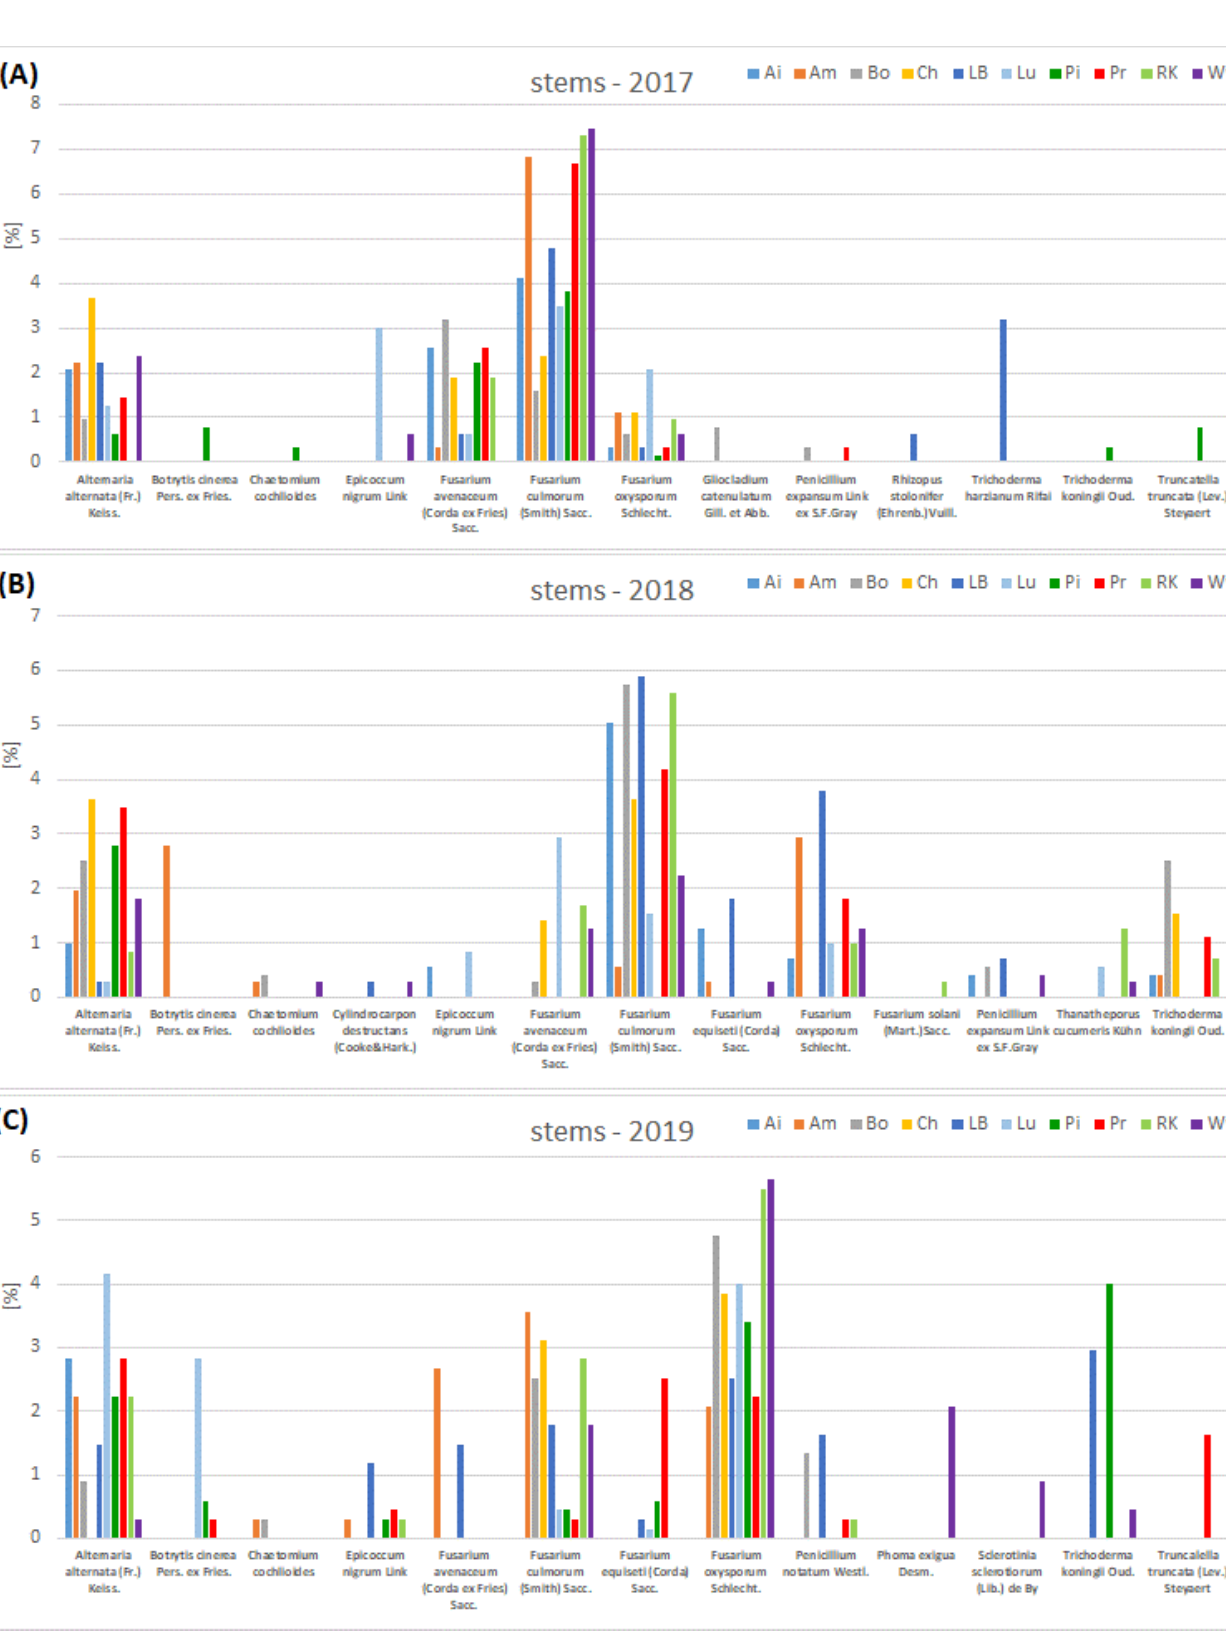
Figure 8. Fungi colonizing stems of canna in particular year of research. Description of cultivars is given in Materials and Methods Section 2.1.